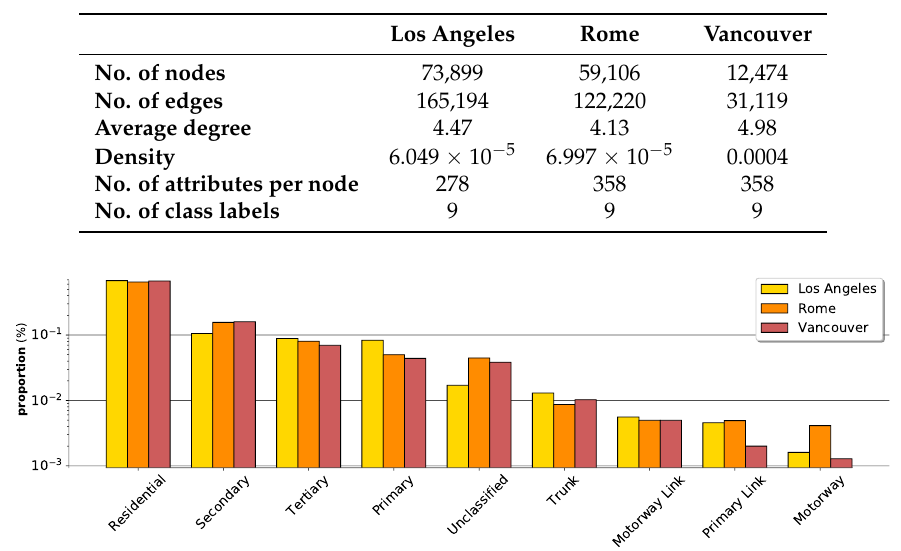
Table 2. Summary of datasets.